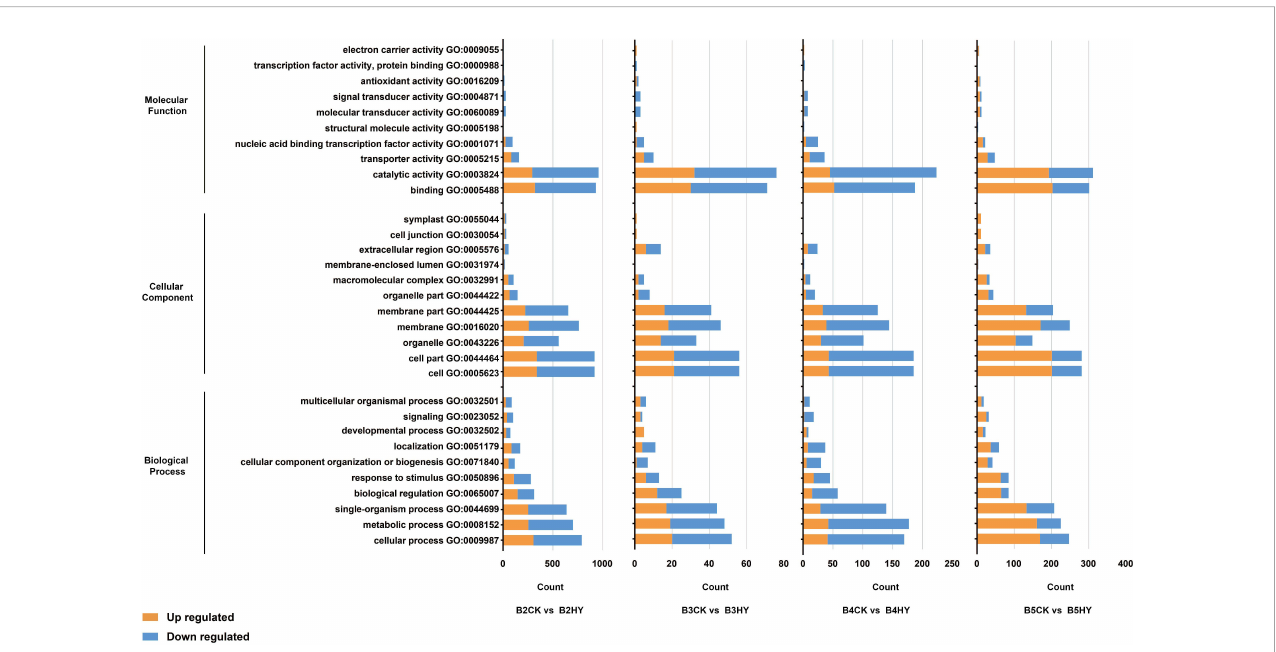
FIGURE 3 Comparison of hyperoside- and control-treated Gemstone seedless grapes at the B2, B3, B4, and B5 stages using GO enrichment analysis of differentially expressed genes (DEGs). The B2, B3, B4, and B5 stages stand for the early stage color transformation, the stage of color turning, the early maturity stage and the full maturity stage, respectively. Yellow represents up-regulated and blue represents